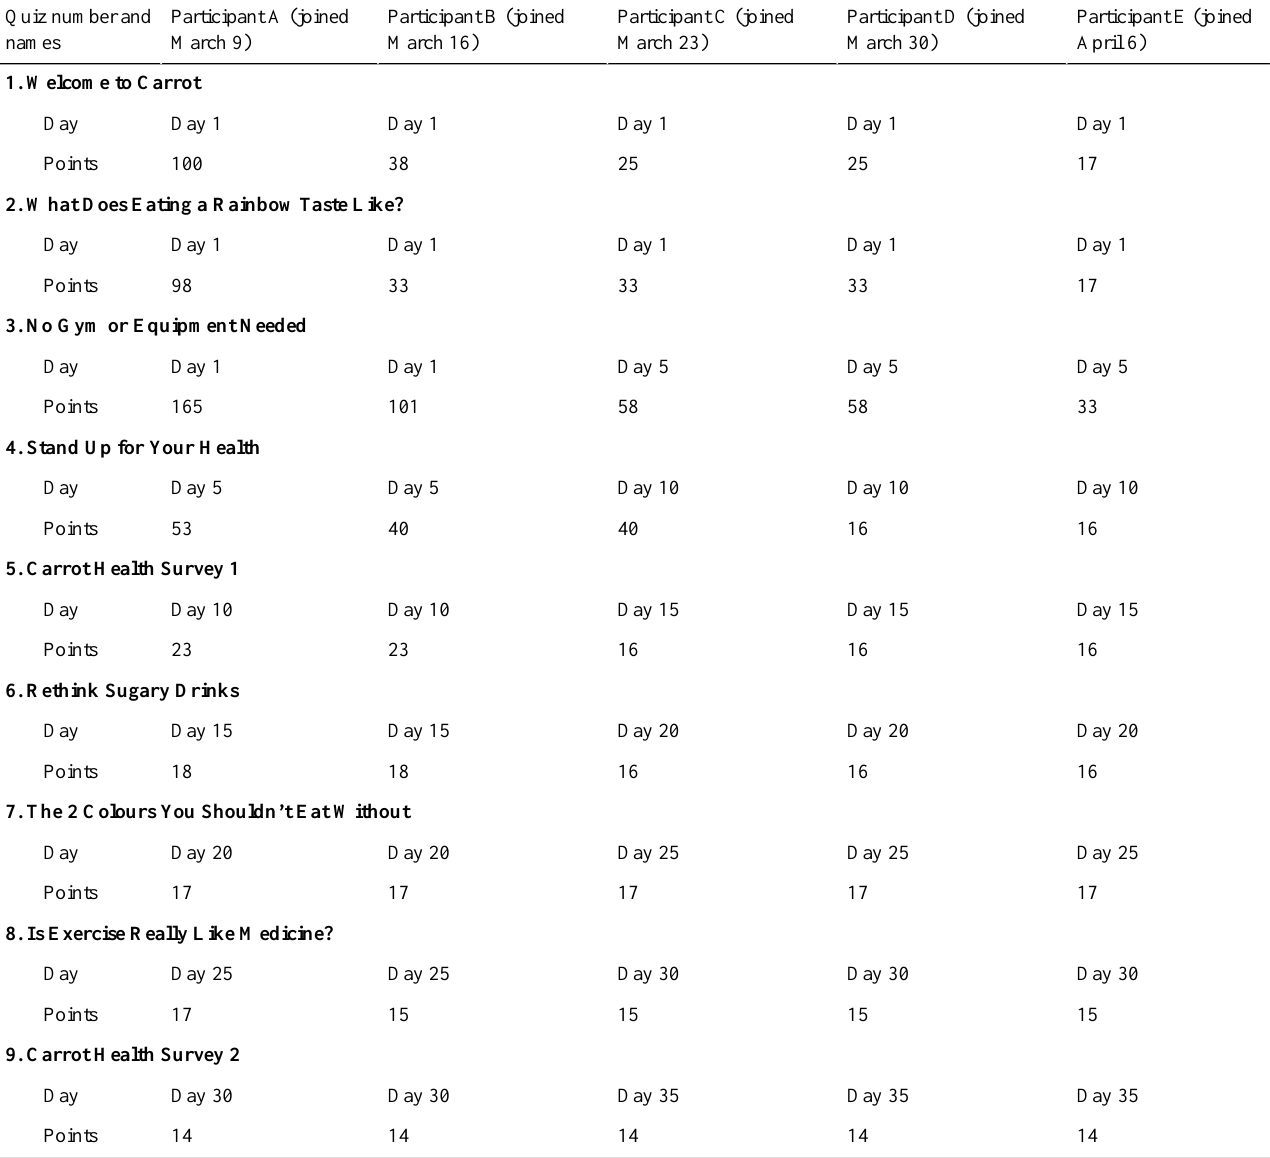
Table 1. Sample profiles of points awarded for quiz completion by initial registration date (Movie Reward Program).